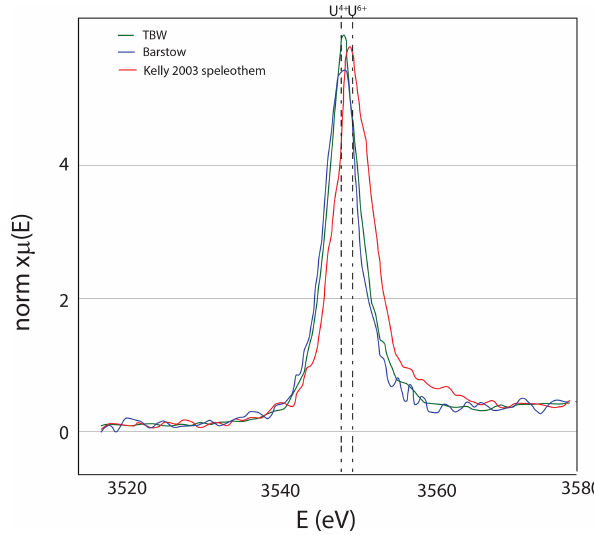
Figure 22. U M 5 edge spectroscopy of the TBW sample show- ing that uranium is in the reduced state; for reference, the U 6 + speleothem of Kelly et al. (2003) is also shown. Both samples were measured at the TES beamline as described in Fig. 8.